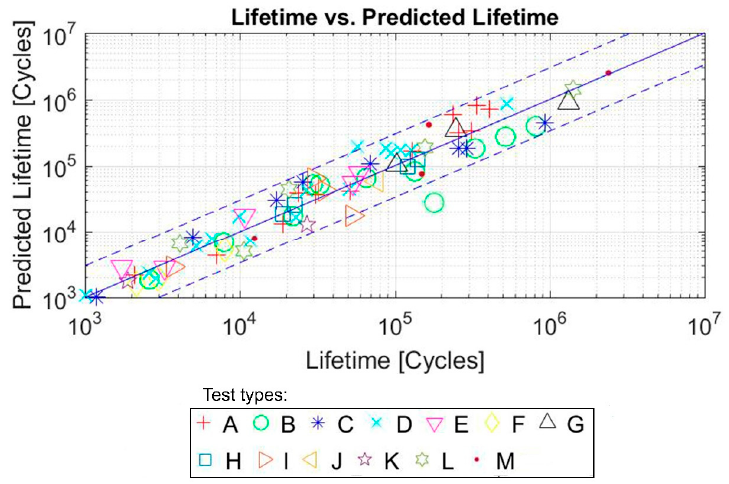
Figure 13. Predicted life with FDMP (cycles) versus real life (cycles) for NBR. Initial data from [45].